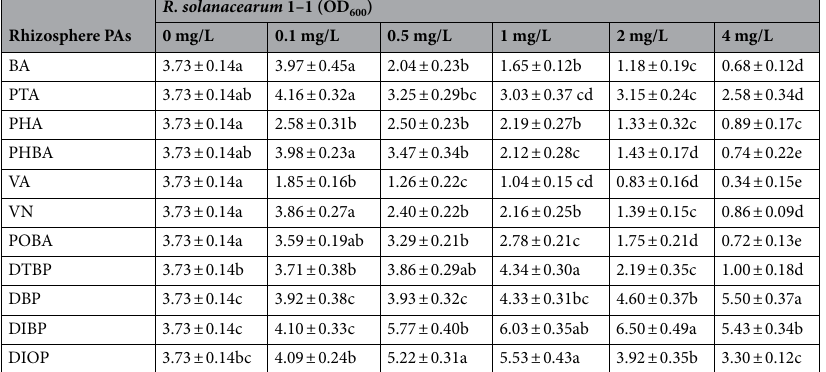
Table 2. The effects of different concentrations of rhizosphere phenolic allelochemicals (PAs) on the growth of R. solanacearum 1–1 (OD 600 ). *Different letters indicate significant difference ( P < 0.05) according to Duncan’s multiple range test.